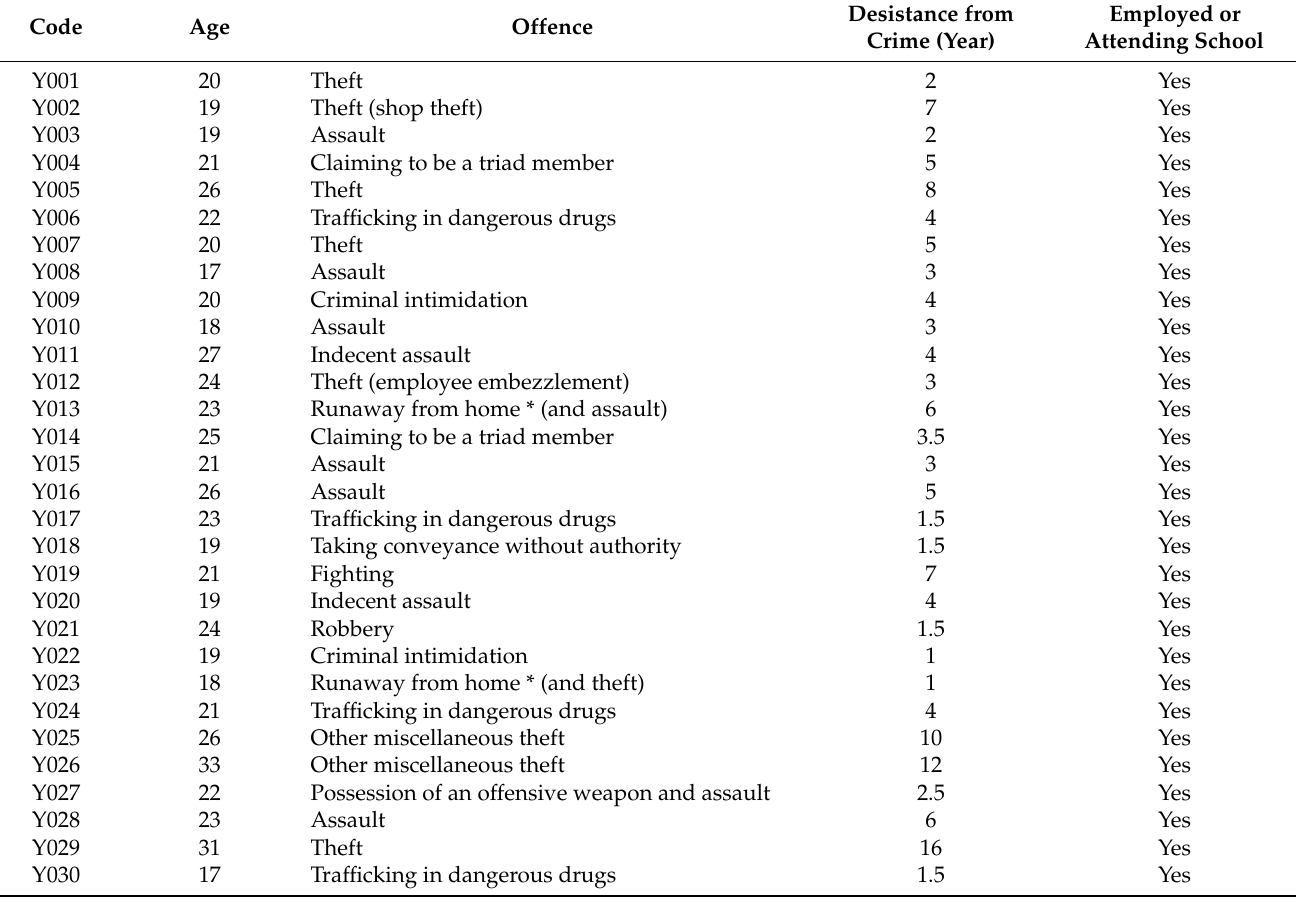
Table 1. Delinquent Youth Sample Characteristics.